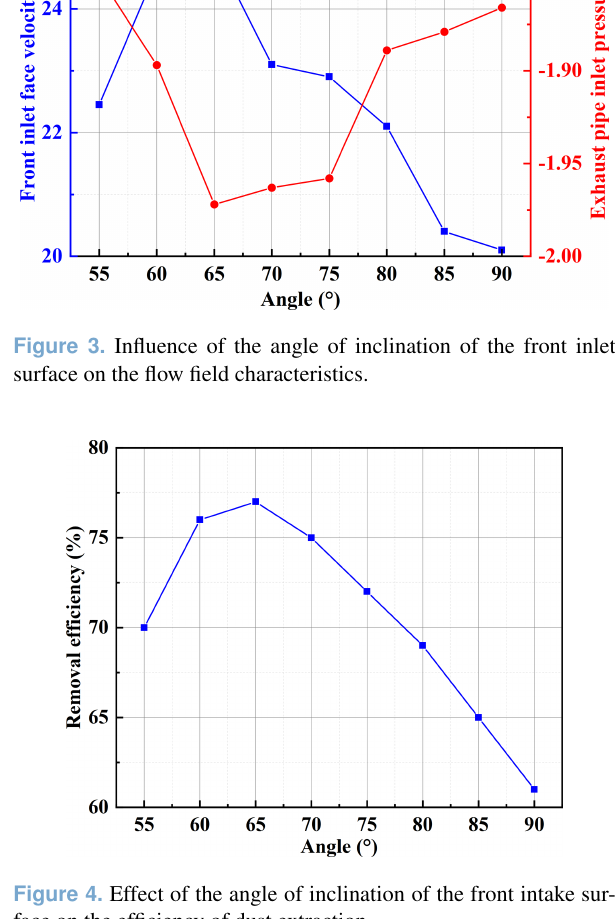
Figure 4. Effect of the angle of inclination of the front intake sur- face on the efficiency of dust extraction.